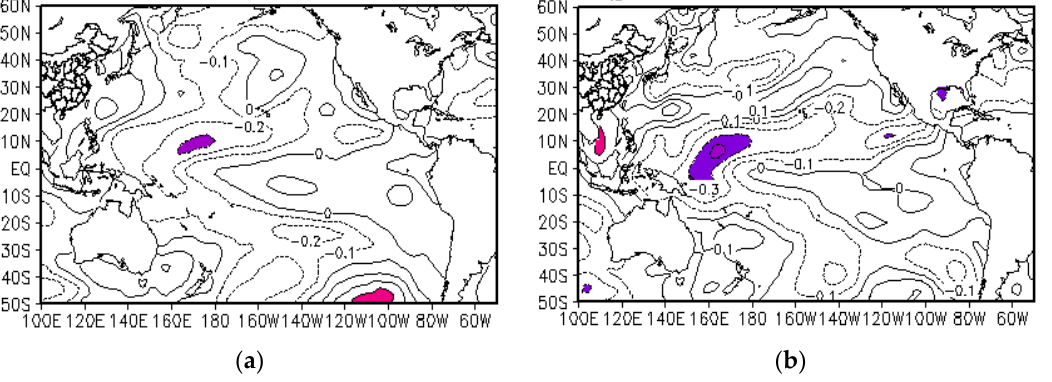
Figure 5. The correlation distribution between the rainfall in PFSSC and the Pacific Ocean temperature, January–March ( a ), April–June ( b ) (shaded area indicates 0.05 confidence level, contour interval 0.1).